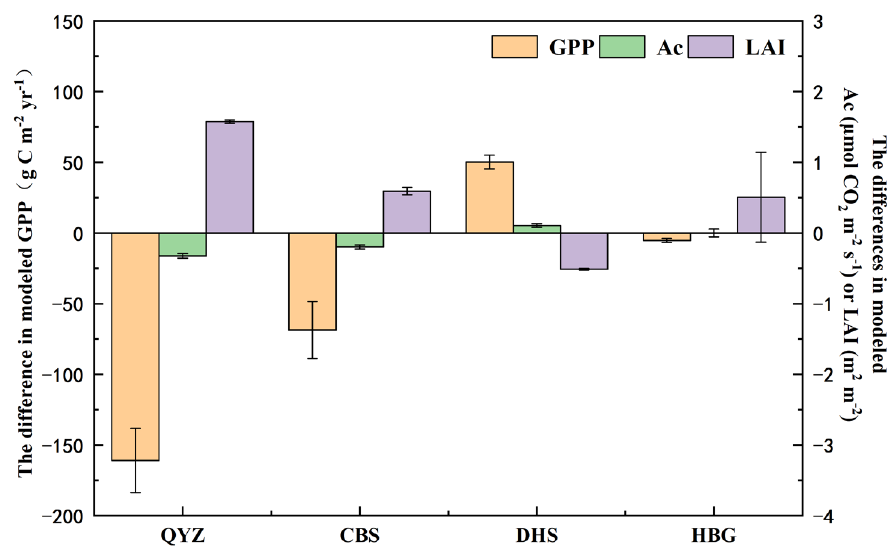
Figure 5. The differences in annual gross primary productivity (GPP), mean RuBP-limited photosynthesis rate (Ac), mean leaf area index (LAI) between model experiment S1 (with default SLA values in the CLM4.5 model) and model experiment S2 (with mean SLA observed values). The error bar shows the standard deviation. QYZ site: temperate needleleaf evergreen tree; CBS site: temperate broadleaf deciduous tree; DHS site: broadleaf evergreen tree; HBG site: C3 grass.